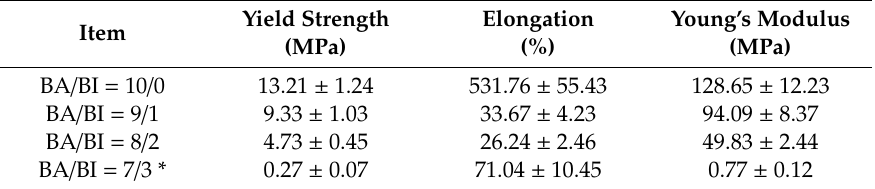
Table 5. Mechanical properties of the PBABI copolyesters.